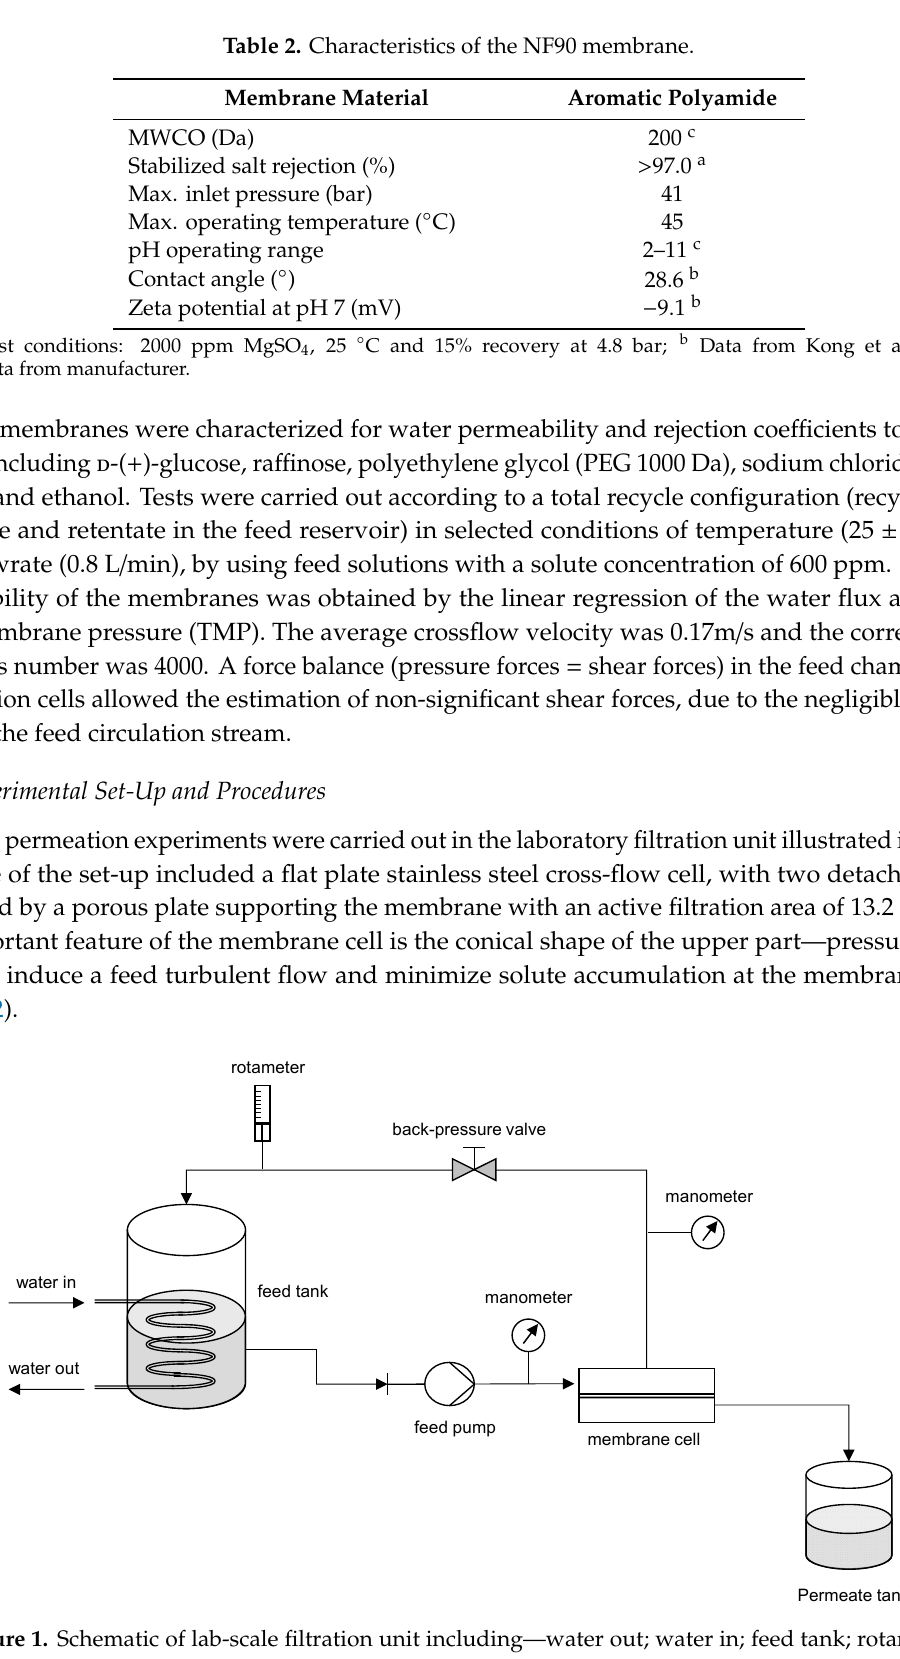
Figure 2. Cross-section of the membrane cell. 1. Feed inlet; 2. Feed outlet; 3. Permeate stream; 4. Porous stainless-steel plate (membrane support). Figure adapted from [34]. Before the permeation tests, the membranes were compacted by circulation of deionized water at constant operating pressure of 35 bar for 2 h, in order to minimize any effect on the membrane structure during the tests, due to the pressure to which they are subjected, and to obtain a steady flux. Experiments were carried out in recirculation mode with the retentate being recirculated into the feed tank, in selected conditions of temperature (25 ± 1 °C) and pressure (20 bar). Approximately 5 L of pomace extract were used as feed. The permeate flux ( J p ), expressed as L/m 2 h, was calculated as follows: 𝐽 (cid:3043) = 𝑉 (cid:3043) 𝐴 × 𝑡